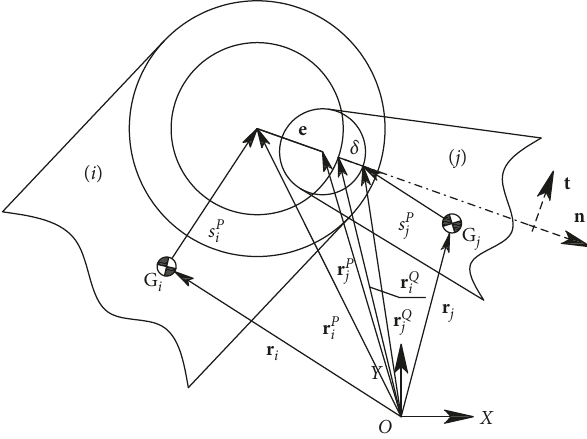
Figure 3: Revolution joint with a clearance